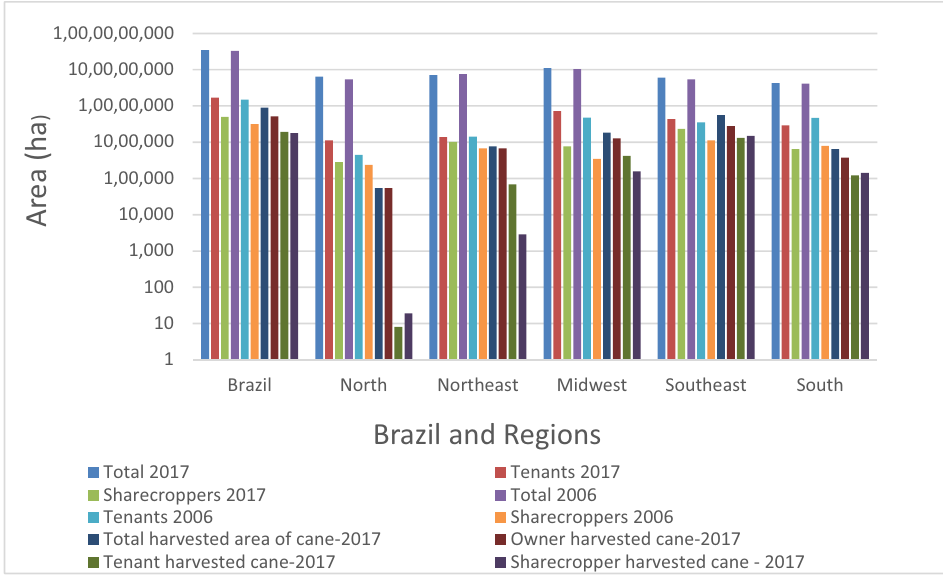
Figure 1: Comparison of total area of agricultural establishments 2017/2006 and the total harvested area of sugarcane in 2017 according to the condition of the producers for Brazil and regions. Source: Own elaboration from ref. [ 47 ]